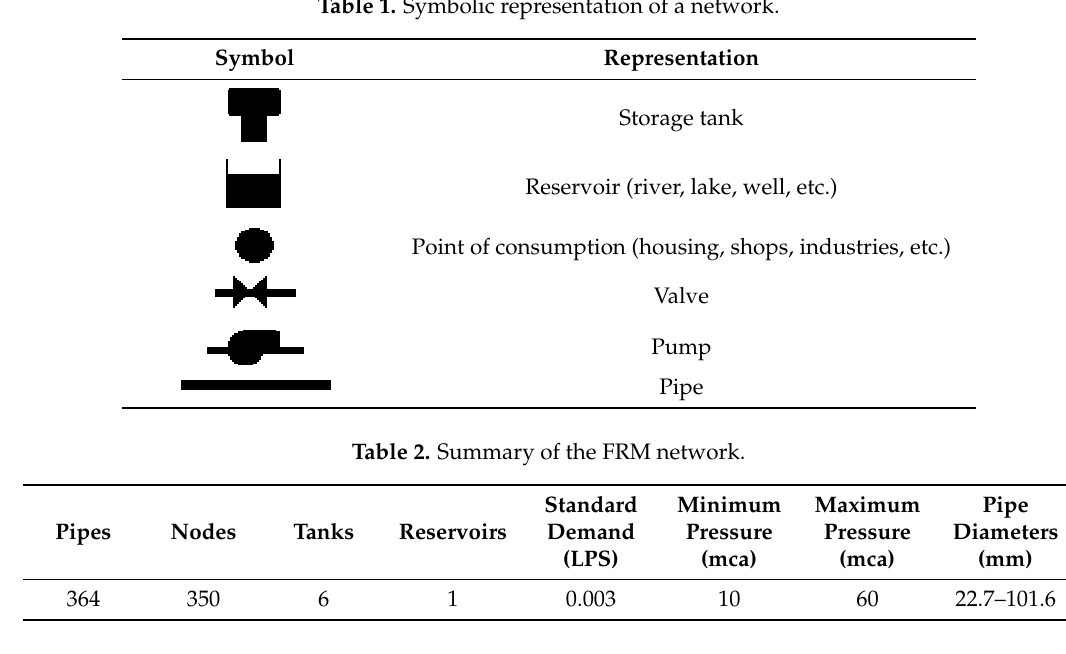
Table 1. Symbolic representation of a network.